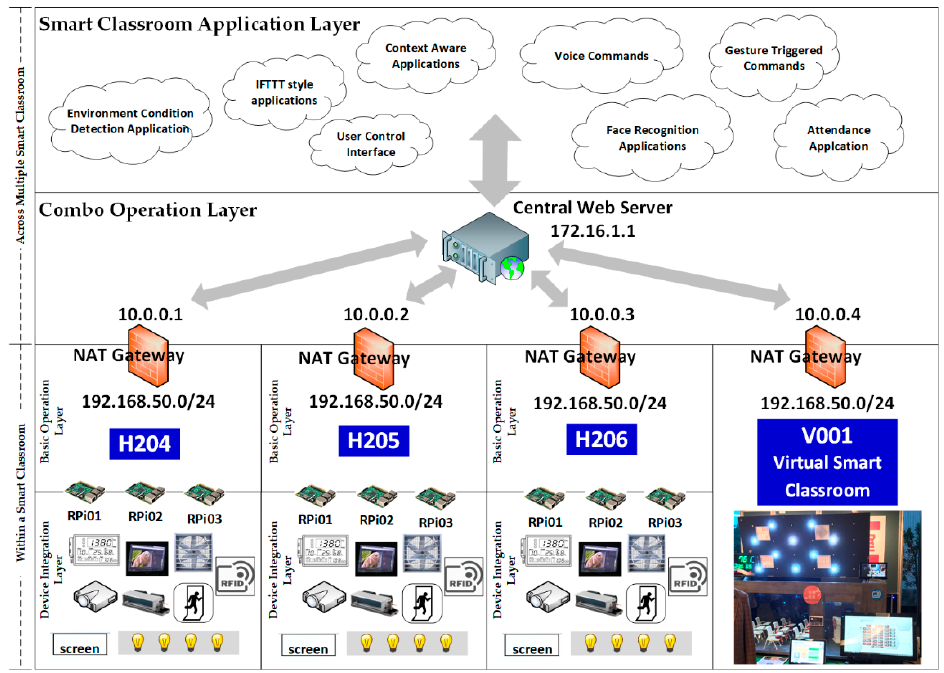
Figure 18. A campus-wide view of the smart classrooms based on the proposed architecture.